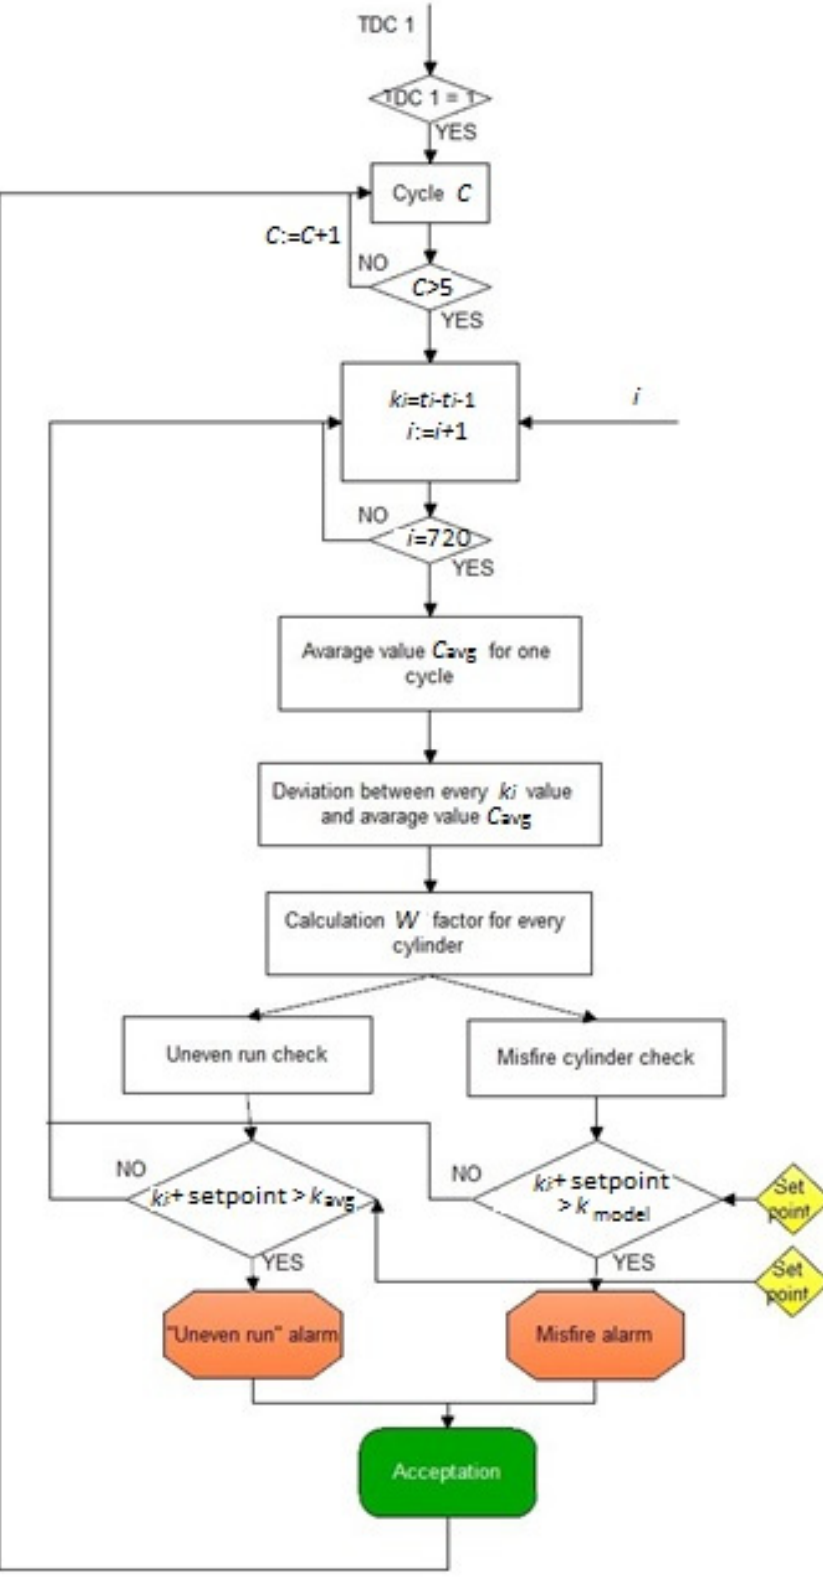
Figure 10. Engine cylinder misfire detection algorithm.